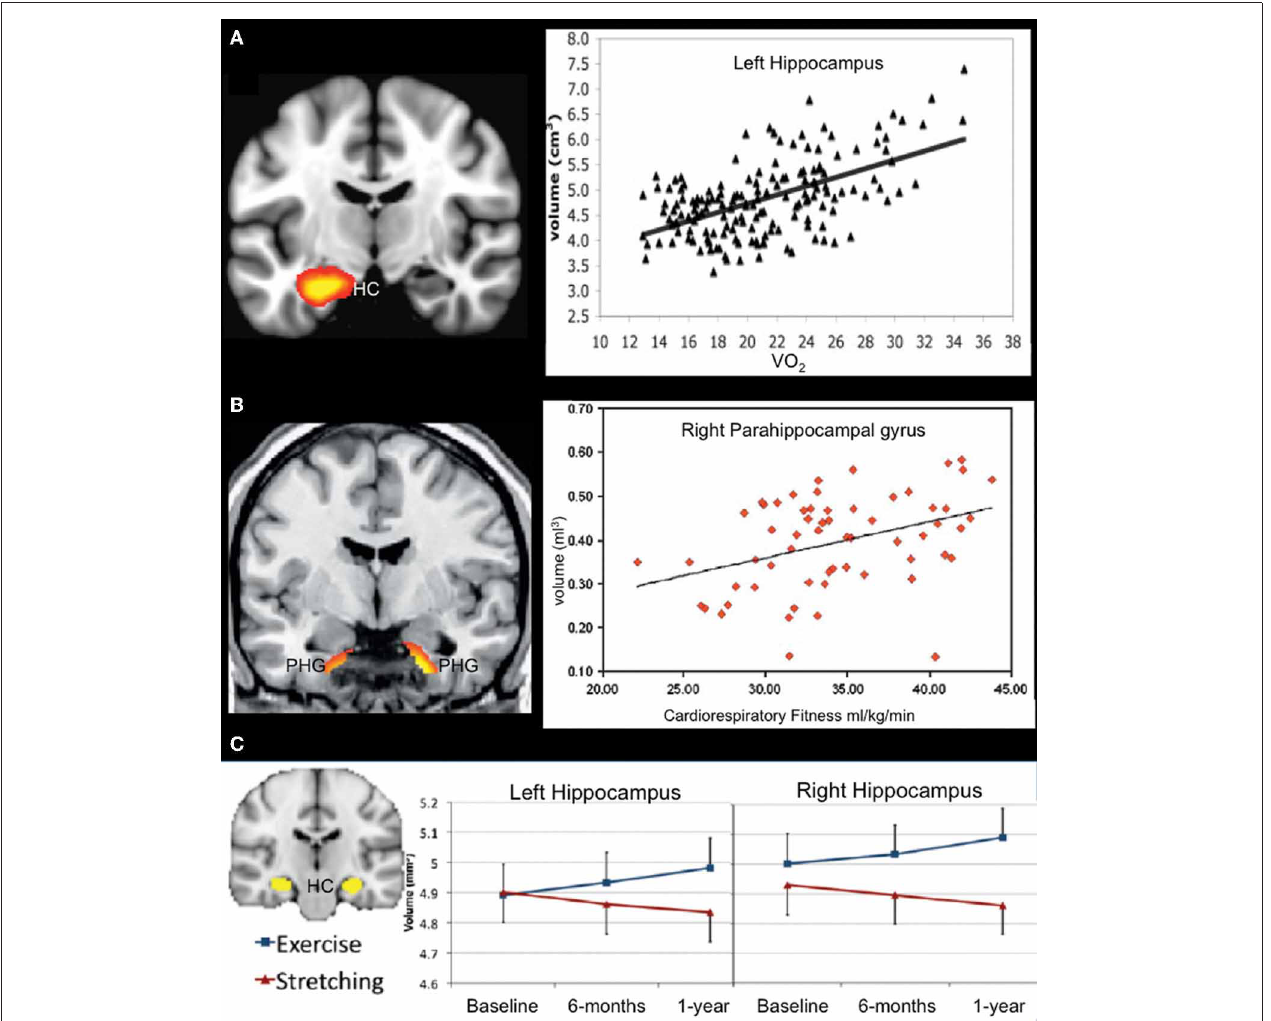
FIGURE 3 | Structural MRI studies using a regions-of-interest approach showing a positive relationship between fitness levels and medial temporal lobe volume. (A) Aerobic fitness is associated with bilateral hippocampal volume in older adults (only data from left hippocampus are displayed). From Erickson et al. (2009), Figure 2, p. 1034. Adapted with permission. (B) Increased